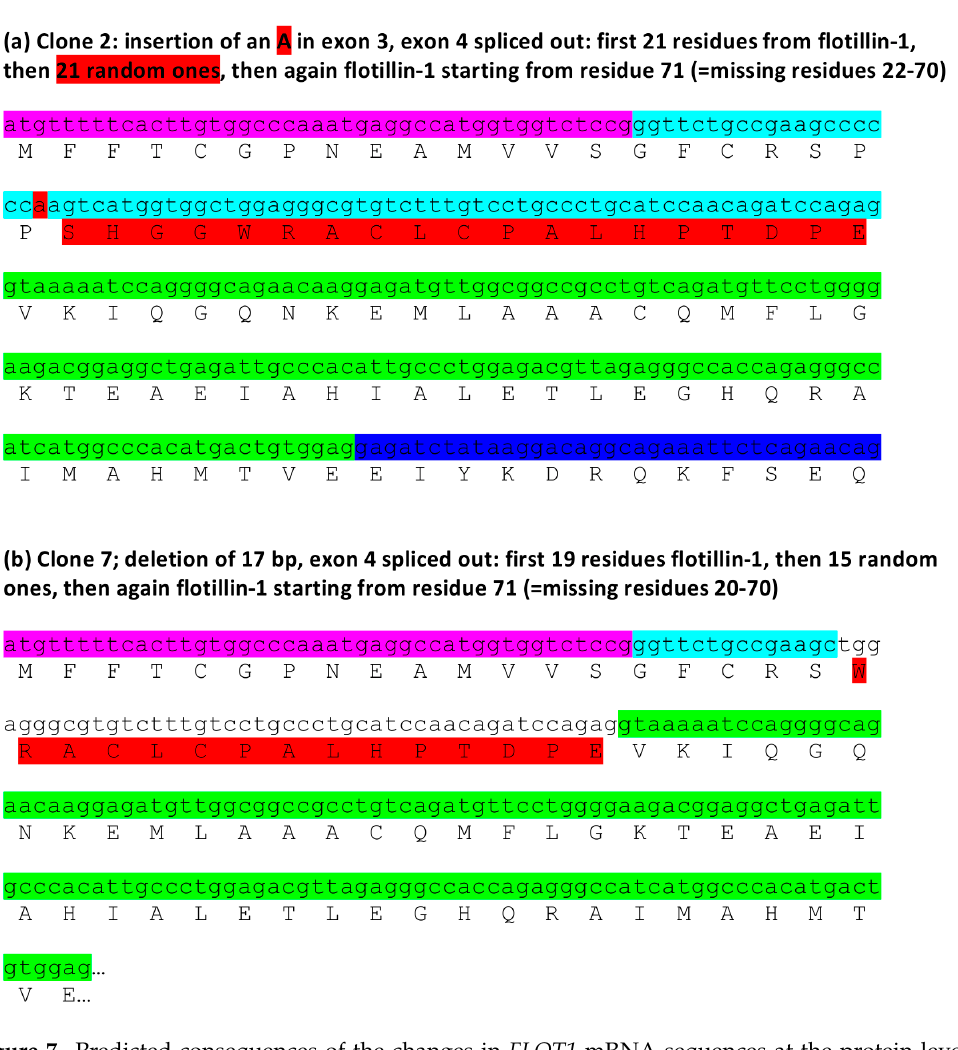
Figure 7. Predicted consequences of the changes in FLOT1 mRNA sequences at the protein level: putative residual protein products. ExPasy Translate tool was used to convert the sequencing data to protein sequences. Color coding as in Figure 6. ( a ) Clone 2: insertion of an A combined with removal of exon 4 results in a putative protein product that contains the first 21 residues of flotillin-1, then 21 random ones, after which the flotillin-1 sequence continues from residue 71. ( b ) Clone 7: deletion of 17 bp, combined with the removal of exon 4 produces a putative protein containing the first 19 residues flotillin-1, then 15 random ones, after which the flotillin-1 sequence continues from residue 71.